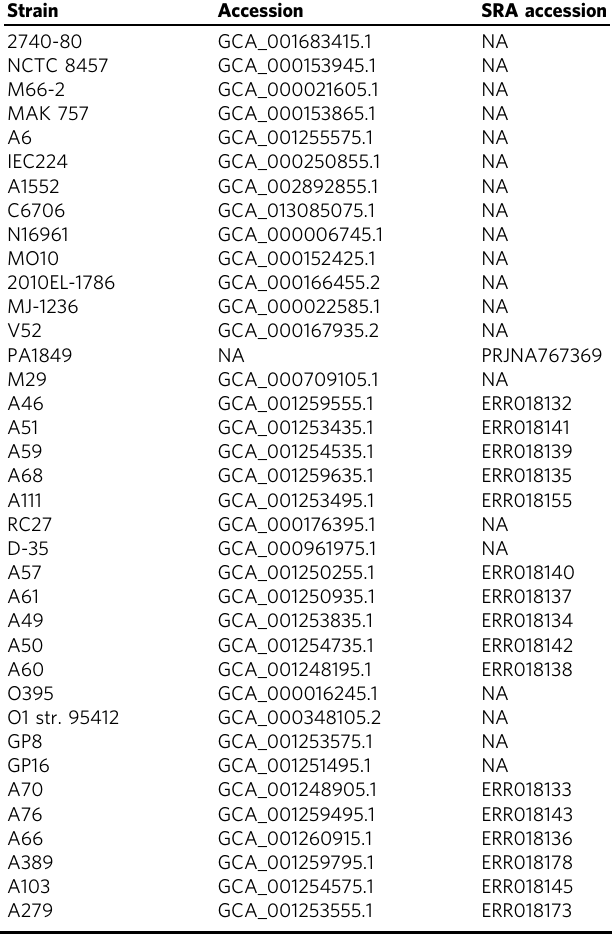
Table 3 A list of genomes and reads used in this study.